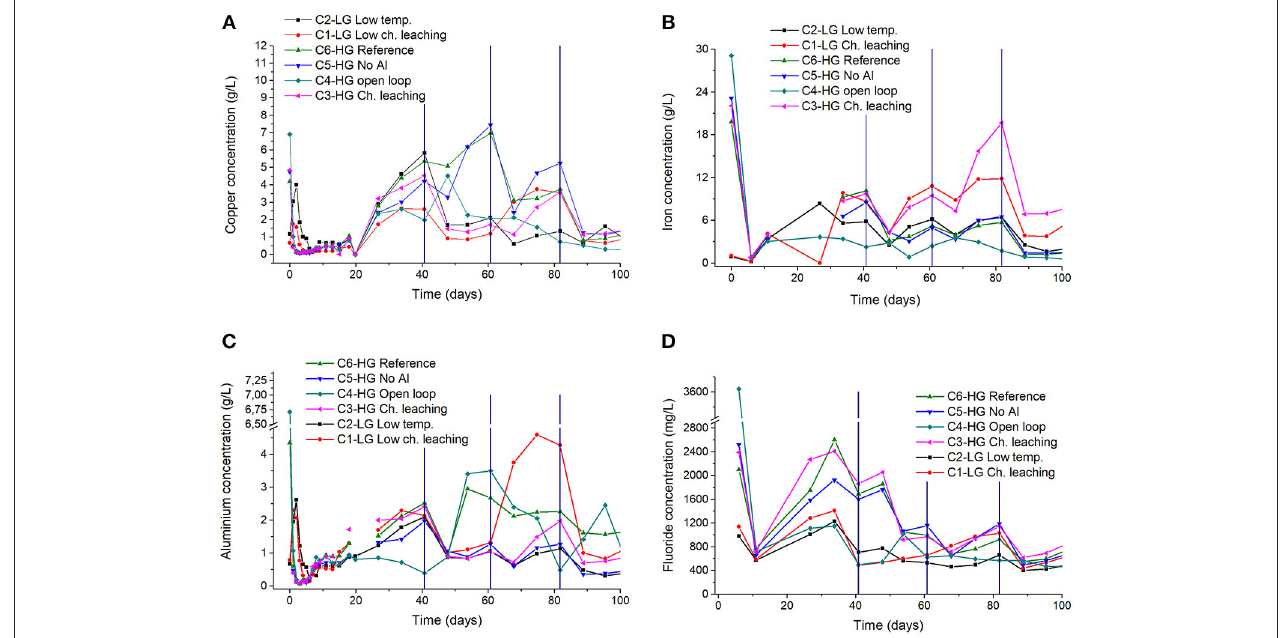
FIGURE 3 | Copper (A) iron (B) aluminium (C) and fluoride (D) concentration in the PLS for high-grade ore (HG) and marginal-grade ore (LG). The vertical lines indicate solution bleeding. Experiments with S. thermosulfidooxidans growing in Norris growth medium supplemented with yeast extract (0.1g/L) and amended with 1.0 g/L Al3 3 + (unless otherwise stated); at 50 ± 1 ◦ C (columns C1, C3–C6) or room temperature (column C2).